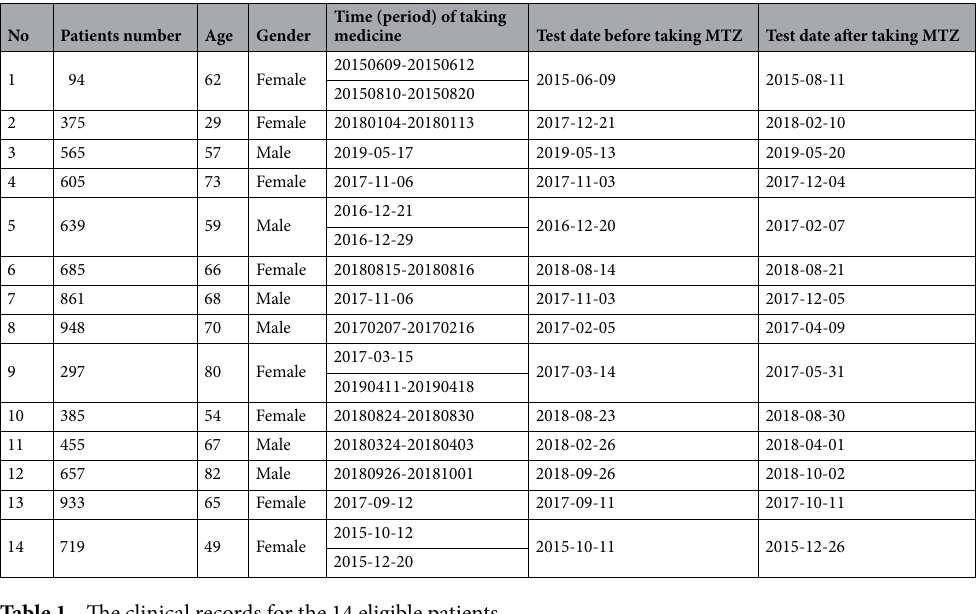
Table 1. The clinical records for the 14 eligible